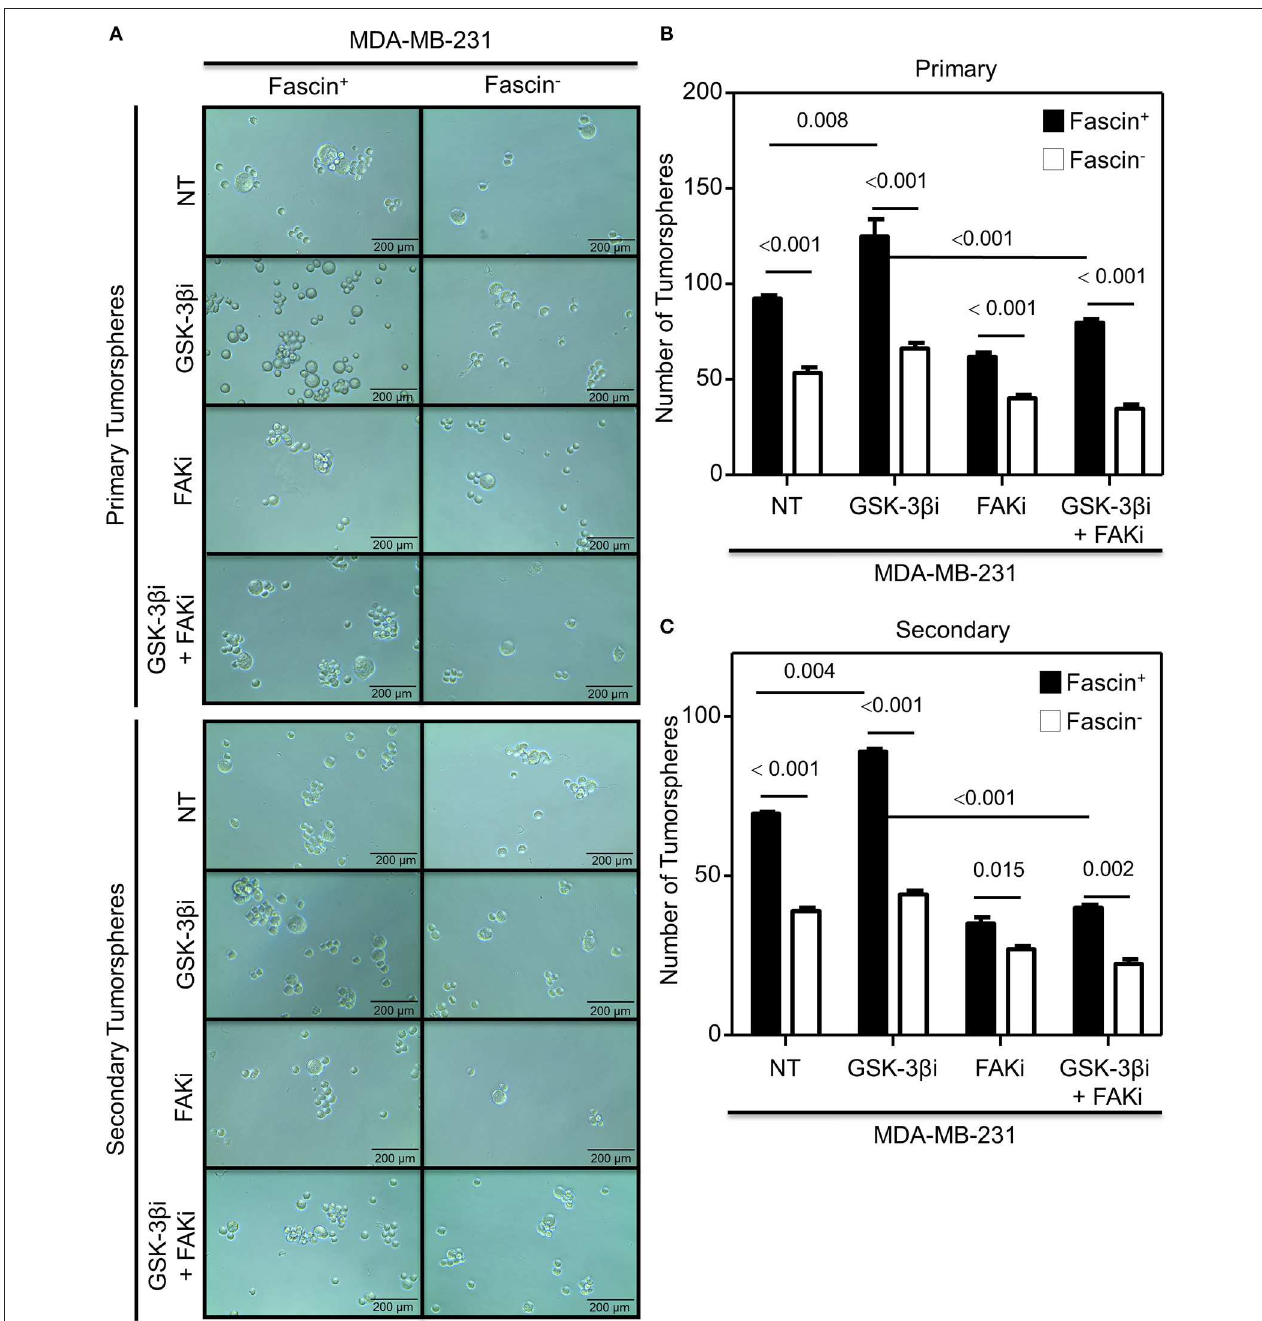
FIGURE 3 | (A–C) Fascin activation of β -catenin signaling pathway enhances tumorsphere formation in a FAK-dependent manner. Bar graph showing the number of tumorspheres formed by fascin + and fascin − MDA-MB-231 cells before and after treatment with GSK-3 β i ± FAKi. (A) Representative images showing primary (top) and secondary (bottom) tumorsphere formed by fascin + and fascin − MDA-MB-231 cells before and after treatment with GSK-3 β i ± FAKi. Bar graphs showing primary (B) and secondary (C) tumorspheres as mean of five replicates ± SD of three independent experiments.